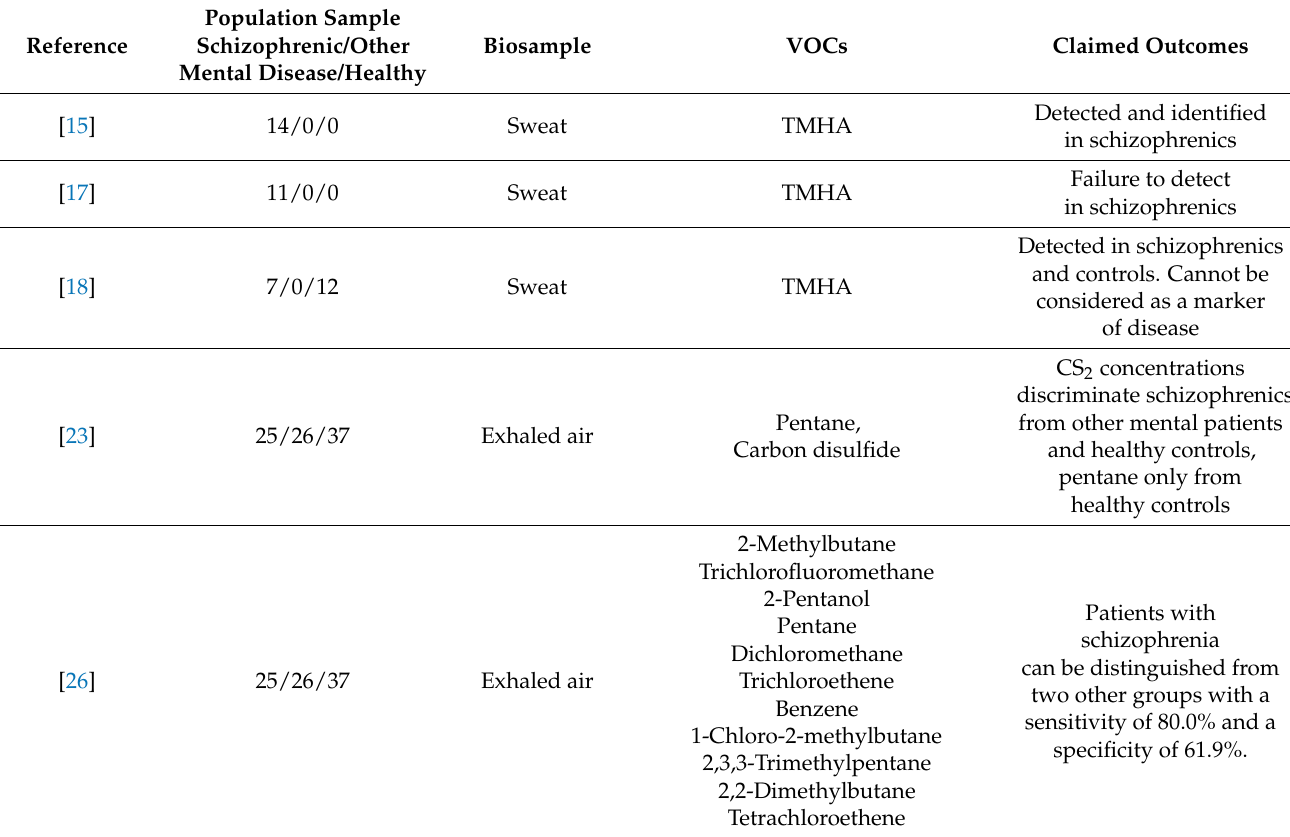
Table 1. Studies of excreted volatile organic compounds for the identification schizophrenia